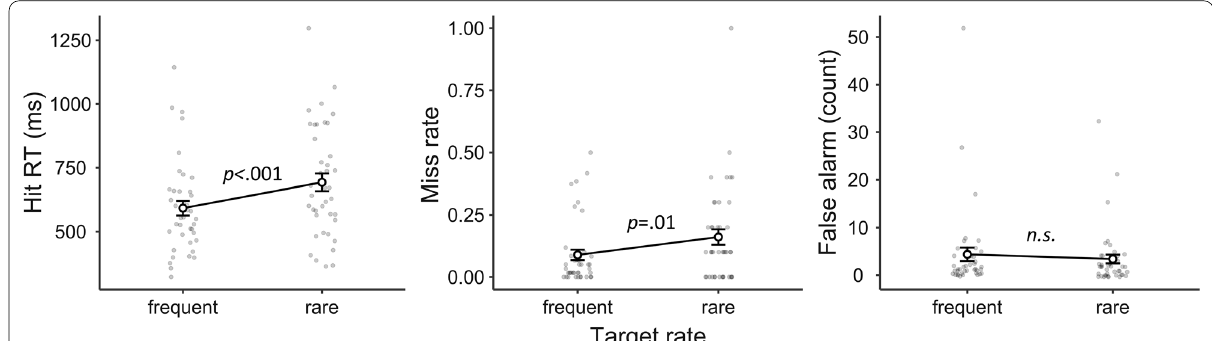
Fig. 2 Experiment 1 Results. Note In Experiment 1, target-rate effects were observed on hit RTs and miss rates, but not false alarms. Error bars represent 1 standard error of the ±